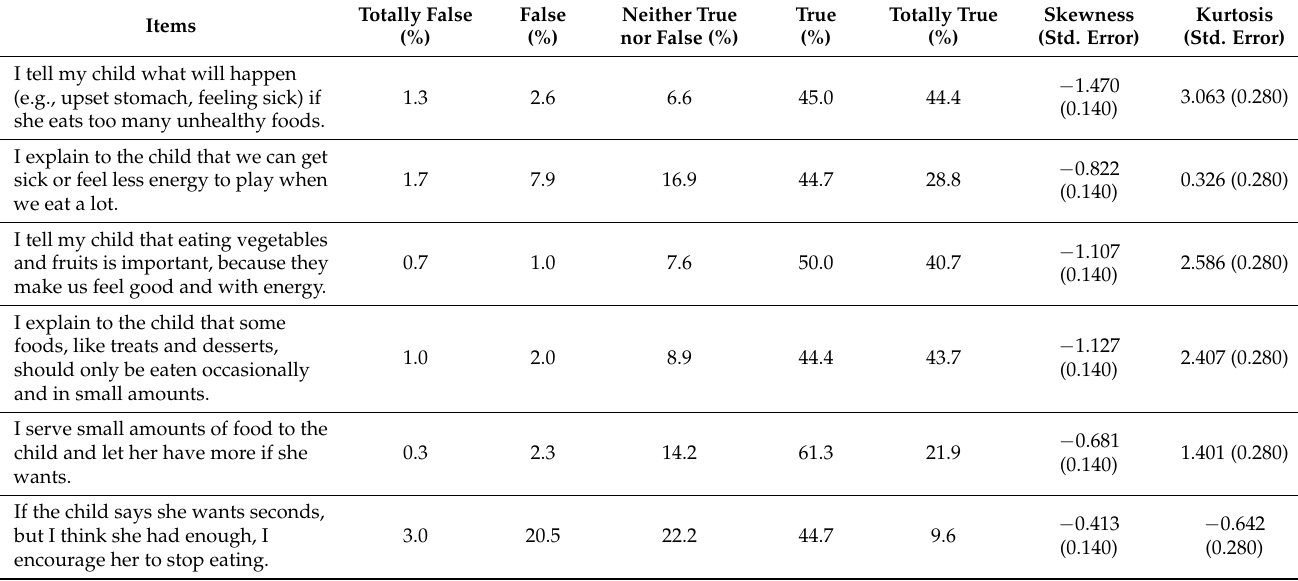
Table 1. Descriptive analysis of the initial items (N =